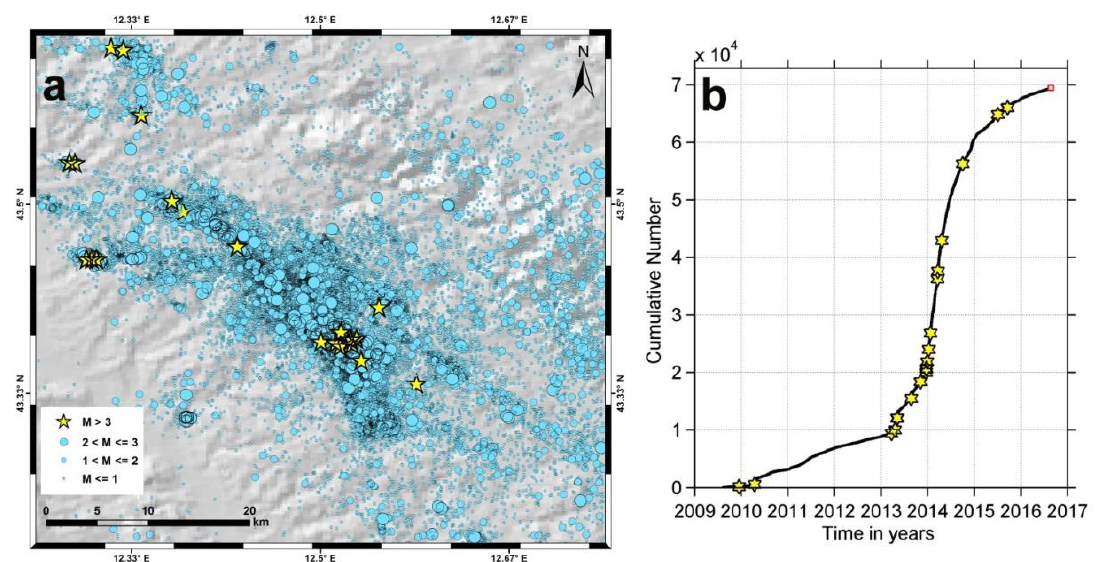
Figure 4. Seismicity of the Gubbio sequence from August 2009 to August 2016: a) seismicity map; b) cumulative number of